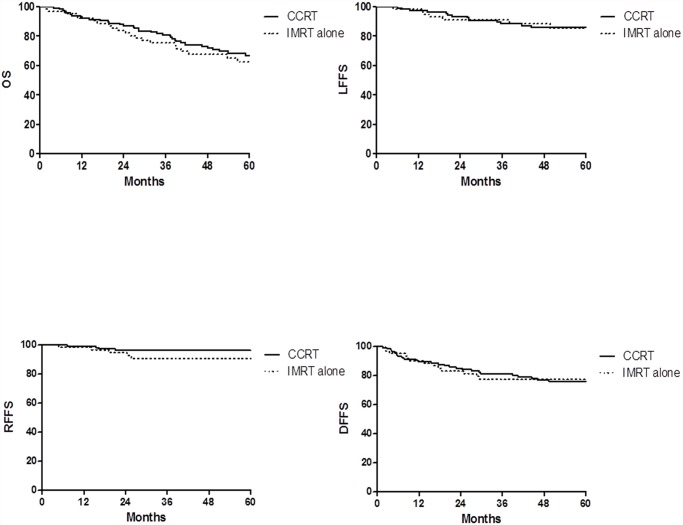
Kaplan-Meier curve showing OS, LRRS, RFFS and DFFS of patients with T4 classification NPC treated with IMRT alone or CCRT in the study.